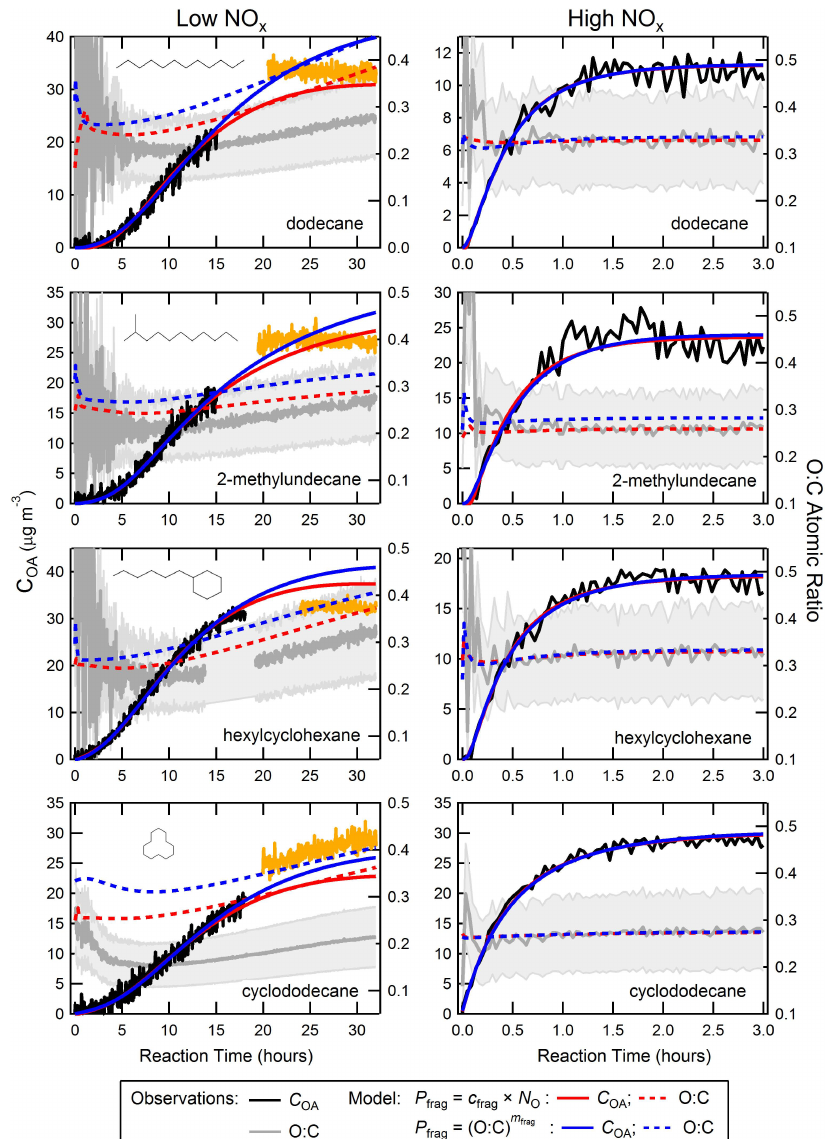
Fig. 1. Evolution of the SOA mass concentration, C OA , (black lines, left axes) and O:C atomic ratio (gray lines, right axes) for low-NO x (left panels) and high-NO x (right panels) for dodecane, 2-methylundecane, hexylcyclohexane and cyclododecane (top-to-bottom). The light gray bands on the O:C indicate the estimated uncertainty range ( ± 30%). The model results using P frag (N O ) and P frag (O:C) are shown as red and blue lines, respectively. Solid lines are model fits for C OA and dashed lines for O:C. The model has been fit simultaneously to the C OA and O:C data for t < 15h (low-NO x , black lines) or t < 3h (high-NO x ). For the low-NO x conditions, the orange lines correspond to data collected after a pause in sampling (indicated by a gap in the C OA time